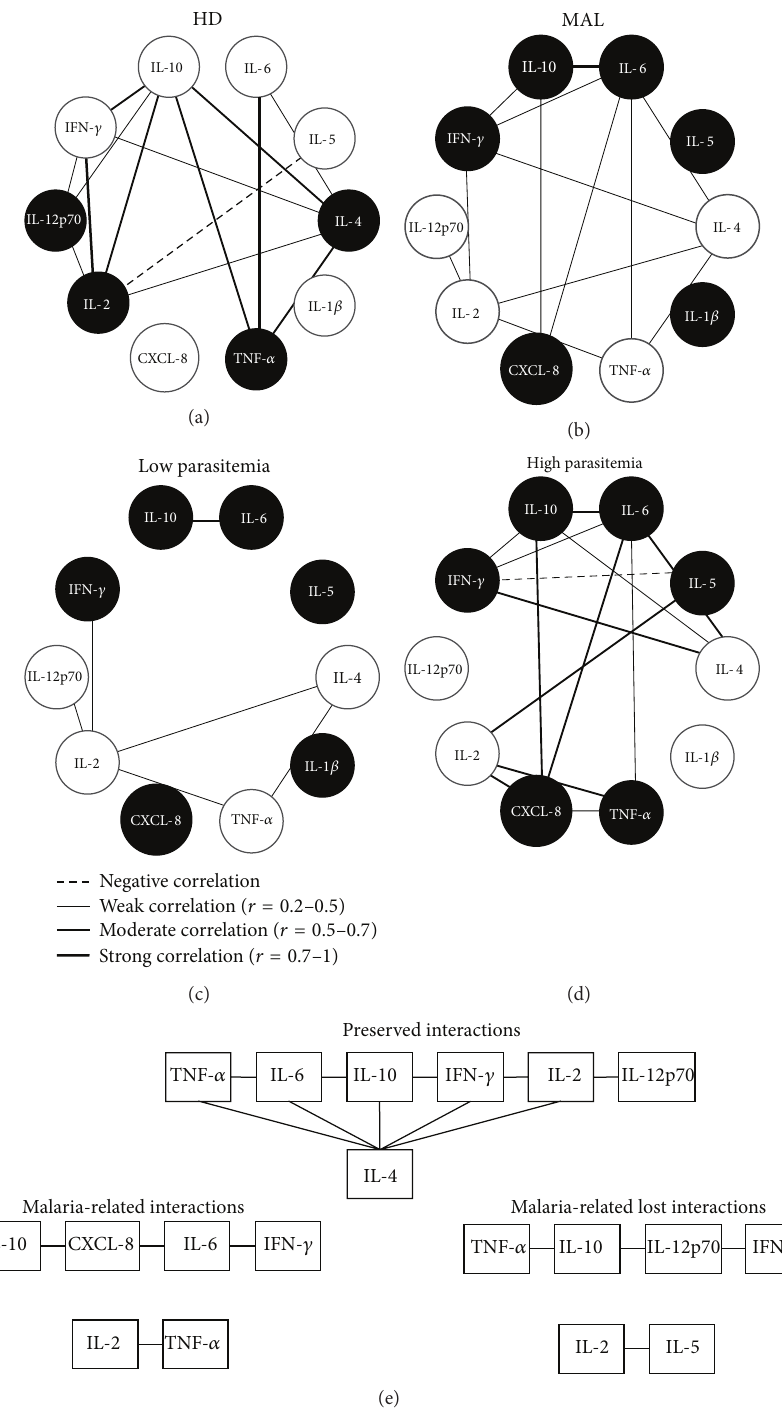
Figure 4: Interactions among serum biomarkers. Plasma levels of IL-1 𝛽 , IL-6, CXCL-8, TNF- 𝛼 , IL-12p70, IFN- 𝛾 , IL-2, IL-4, IL-5, and IL-10 weremeasuredintheserumofhealthydonorsand P.vivax -infectedsubjects.Eachconnectinglinerepresentsasignificantcorrelationbetween a pair of biomarkers. Dashed lines represent negative correlations. Solid lines represent positive correlations, and the degree of significance is represented by the line thickness. Filled circles represent higher producers and open circles represent low producers of a specific biomarker. (a) and (b) represent biomarker interactions in HD (a) and P. vivax -infected subjects (b). (c) and (d) represent biomarker interaction in P. vivax presenting low (low) and high parasitemia (right). (e) represents biomarkers interactions that are preserved upon P. vivax infection and interactions gained or lost during malaria. Circle layouts underscore each biomarker by globular nodes ( ∘ or ∙ , as the comprise < 50% or > 50% frequencies of individuals with high serum levels, resp.). Spearman “ 𝑟 ” indexes were used to classify the connecting edges as negative, moderate, or strong positive correlation, as shown in the